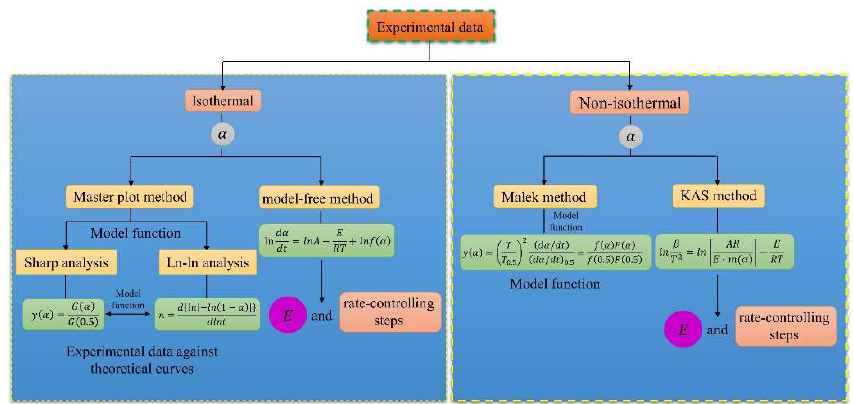
Figure 3. Flowchart for determination of macro-kinetics triplet.